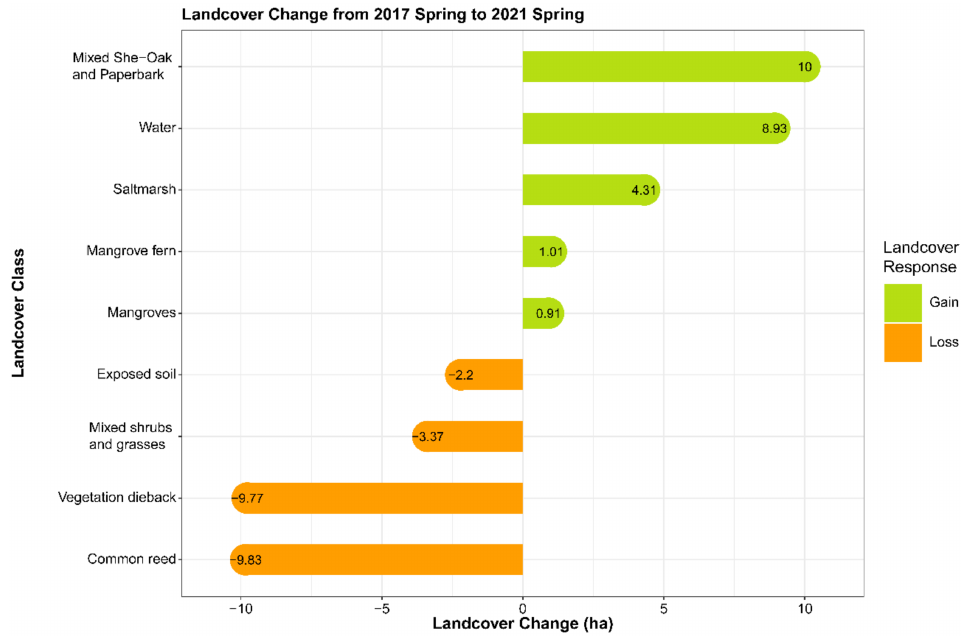
Figure 5. Changes in the area of each of the nine land cover classes between spring 2017 and 2021.